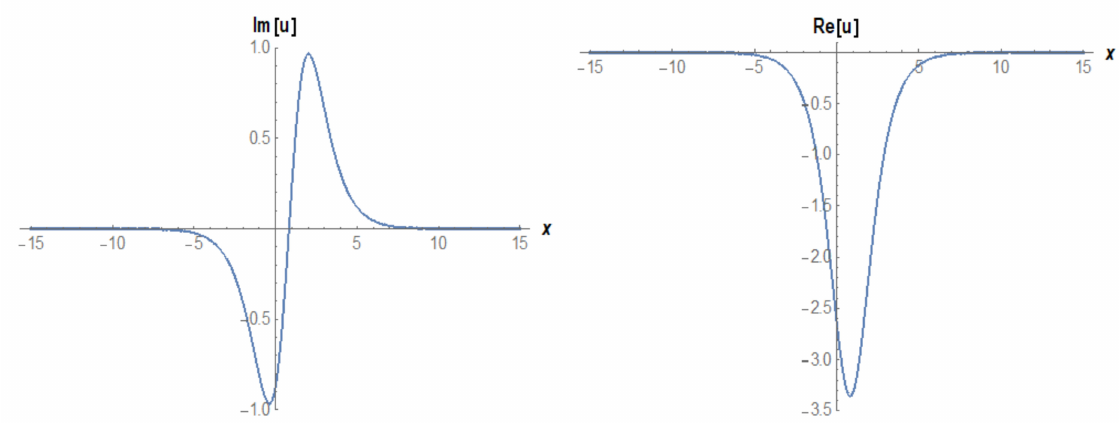
Figure 22. The 2D surfaces of Equation (32) for ε = 0.4, α = 0.1, t = 0.5, − 15 < x <